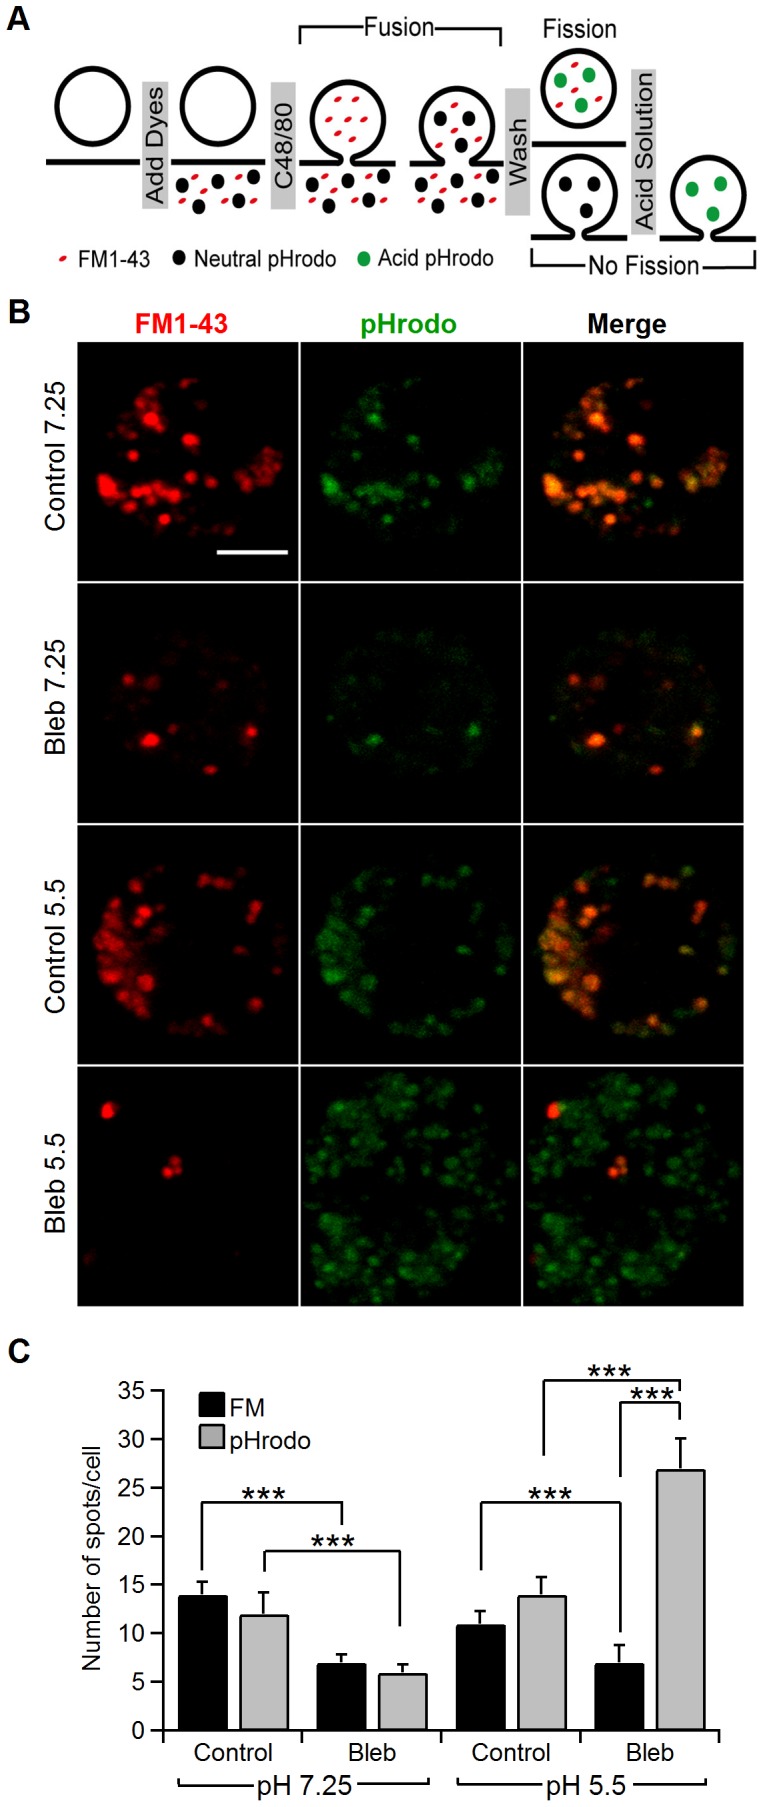
NM-2 inhibition blocks membrane scission and promotes unclosed vesicles through a narrow neck.Schematic of endocytic spots labelled with FM1-43 and pHrodo Green (A). After addition, the dyes incorporate into exocytic vesicles, which fuse with the membrane upon a stimulus (C48/80). If these vesicles are internalized and acidified, the vesicles will be stained. Therefore, after removing the extracellular dyes, only fluorescent endocytic vesicles remained. The addition of an extracellular acidic solution reveals the presence of uncompleted fission pores. The images in panel B show Z-stack projections from control cells (Control) or cells treated with blebbistatin (5 µM) (Bleb) at pH 7.25 or pH 5.5 after stimulation by C48/80 (100 µg/ml) (B). The stainings from left to right are: FM1-43 (red), pHrodo Green dextran (green) and a merge of FM1-43 and pHrodo Green dextran. The mean number of FM1-43 (black) and pHrodo Green dextran (grey) spots per cell in control conditions at pH 7.25 or pH 5.5 and after treatment with blebbistatin at pH 7.25 or pH 5.5 (C). Scale bar: 5 µm. Error bars, S.E.M. ***p<0.001.